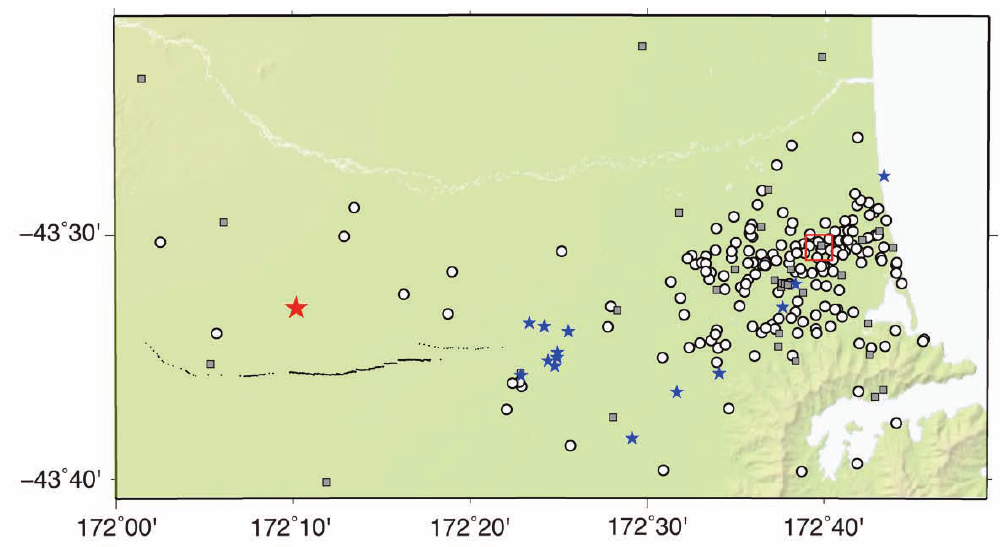
Figure 1. Map of the study area showing QCN (circles) and GeoNet (squares) station locations. Small blue stars indicate M ≥ 4.5 earthquakes that occurred between September 15, 2010, and January 31, 2011, used in this study (Table 1) and large red star indicates the epicenter of the September 3, 2010, M7.1 Darfield mainshock. Red box indicates the zoom region shown in Figure 4.